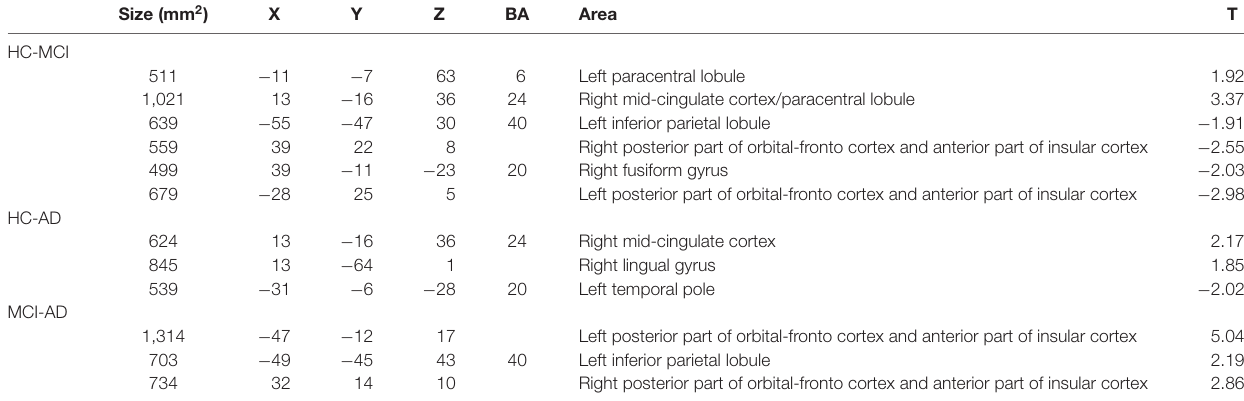
TABLE 2 | Talairach coordinates of clusters showing significant differences in functional connectivity with the cerebellar limbic network between HC, MCI, and AD groups.